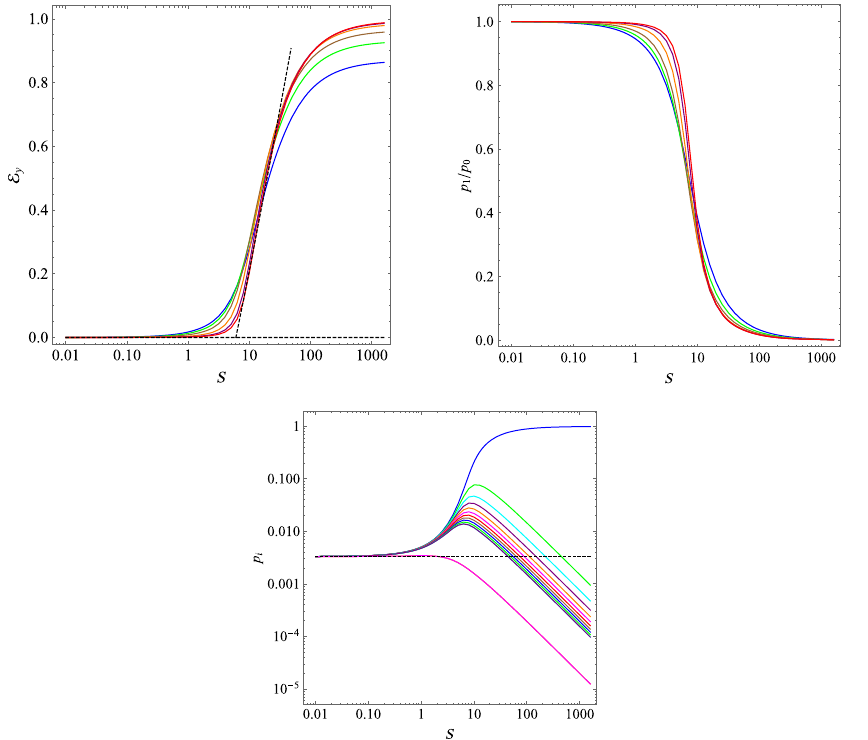
FIG. 2. Classical Fröhlich-like condensation. For an increasing number of modes entering the numerical simulations of Eq. (49), in the upper left panel, the condensation index E , defined in Eq. (50), is reported versus the energy input rate S , and in the upper right panel, y 1 and the ratio of the energy content p 1 =p 0 is reported versus S . At equipartition, E 0 ¼ 0 and p 1 =p 0 ¼ 1 ; for the condensed state, E y ¼ 11 (blue), N 21 (green), N 41 (brown), N 101 (orange), p 1 =p 0 ¼ 0 . The colors of the lines correspond to N sys ¼ sys ¼ sys ¼ sys ¼ 201 (purple), and N 301 (red). The dashed oblique line (tangent to the inflection point of the two highest N curves) is a N sys ¼ sys ¼ guide to the eye to mark a possible asymptotic bifurcation point. In the lower panel, the relative energy content of two groups of modes — p for i ¼ 0 – 10 (from blue to purple) and i ¼ 99 , 100, 101 (blue, green, magenta superposed) — are displayed as a function of S , i 301 . The dashed line corresponds to energy having set N sys ¼